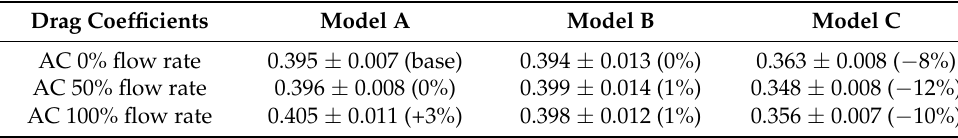
Table 4. Drag coefficients for different geometry models and AC flow